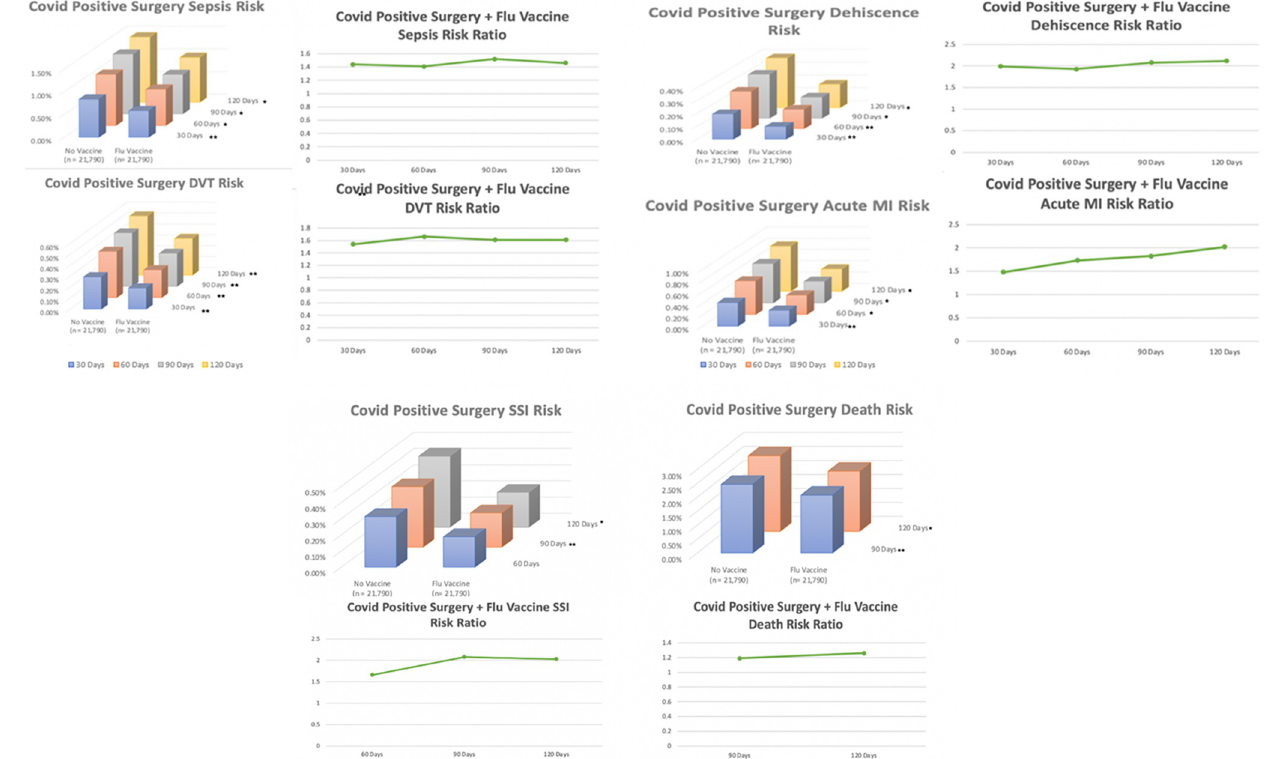
Fig 2. Significantly different ( � ) and nominally significant ( �� ) risks & risk ratios of post-operative adverse outcomes between influenza vaccinated and non-influenza vaccinated patients within 30–120 days (Fig 2a) and 90–120 days (Fig 2b) of surgery. � denotes statistical significance following Post-Hoc testing for Multiple Hypotheses using Bonferroni Correction to alpha level of p = 0.0011, �� denotes nominally significant values (p < 0.05) that failed to meet statistical significance following Bonferroni correction of p =